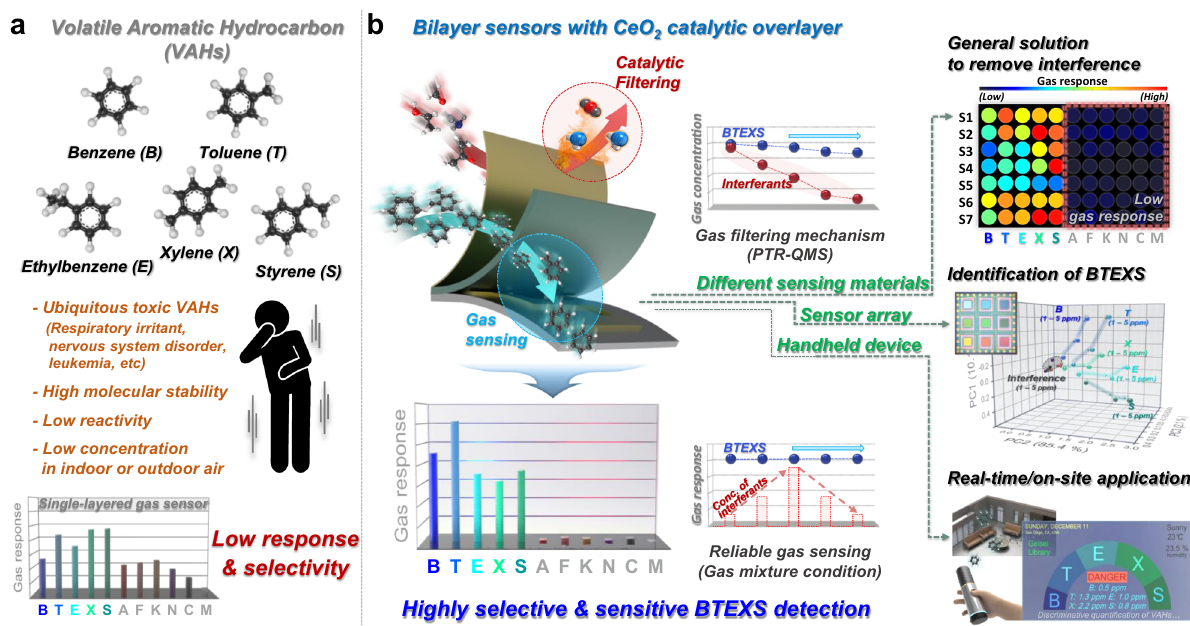
Fig. 1 | Concept of this study. a Obstacles for detecting volatile aromatic hydro- carbons (VAHs, i.e., benzene (B), toluene (T), ethylbenzene (E), xylene (X), and styrene(S)). b BilayersensorwithcatalyticCeO 2 overlayersuggestedasauniversal